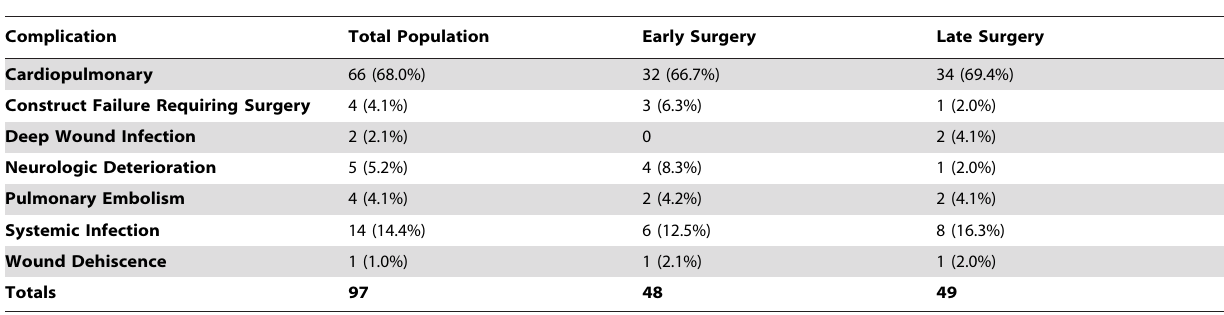
Table 7. Inpatient Postoperative